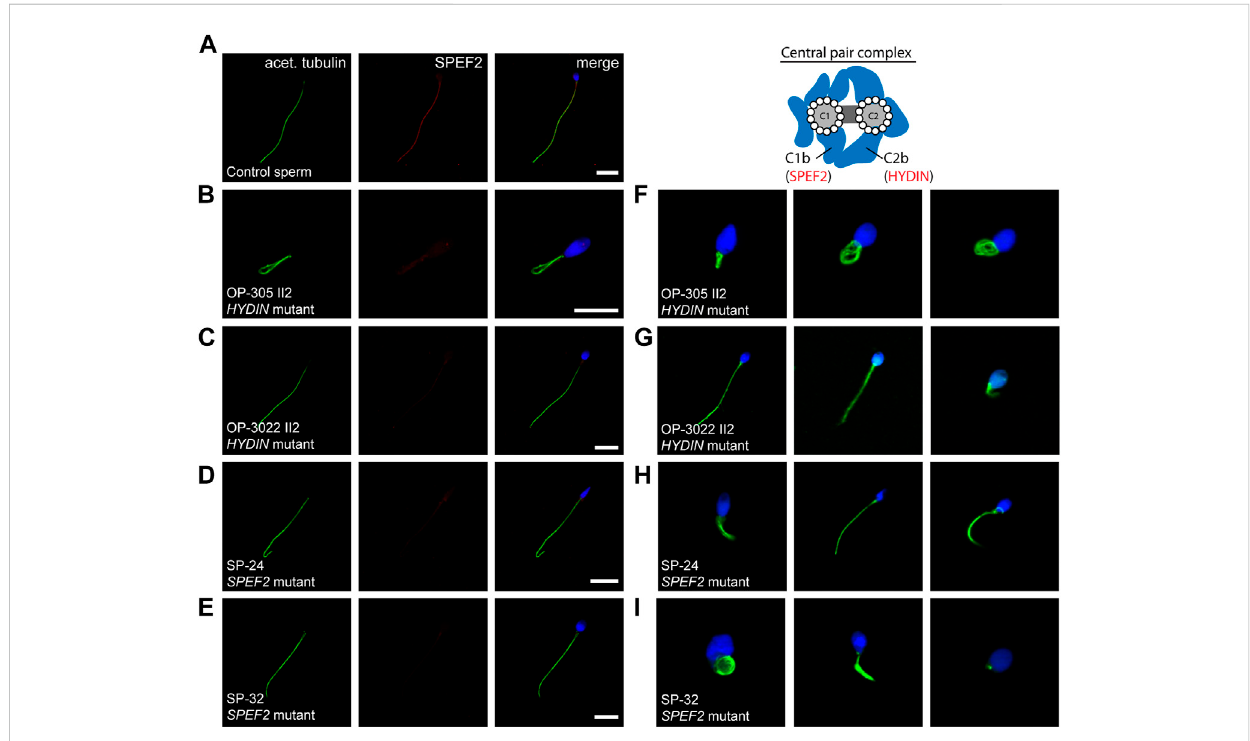
FIGURE 6 SPEF2 is absent or severely reduced in sperm fl agellar axonemes of HYDIN - and SPEF2 -mutant individuals, presenting with MMAF-associated infertility. Sperm cells from healthy control donors and infertile male individuals with pathogenic variants in HYDIN and SPEF2 were co-stained with antibodiesdirectedagainstacetylated α -tubulin(acet.tubulin;depictedingreen)andSPEF2(depictedinred). (A) Incontrolspermcells,immunoreactivity against SPEF2 (red) is observed along the entire fl agellar length. The SPEF2 signal co-localizes with the fl agellar marker acet. tubulin (depicted in yellow in the merged image). (B – E) In sperm cells of both HYDIN -mutant individuals (OP-305 II2 and OP-3022 II2) and SPEF2 -mutant individuals (SP- 24 and SP-32), a severe reduction of the SPEF2 signal or no signal against SPEF2 was observed along the fl agellar axoneme. (F – I) Sperm of both HYDIN - and SPEF2 -mutant individuals display a MMAF phenotype with short, bent, coiled and irregular fl agella. The schematic representatively shows the localization of HYDIN and SPEF2 within the central pair associated apparatus. Nuclei were stained with Hoechst33342. Scale bars represent 10